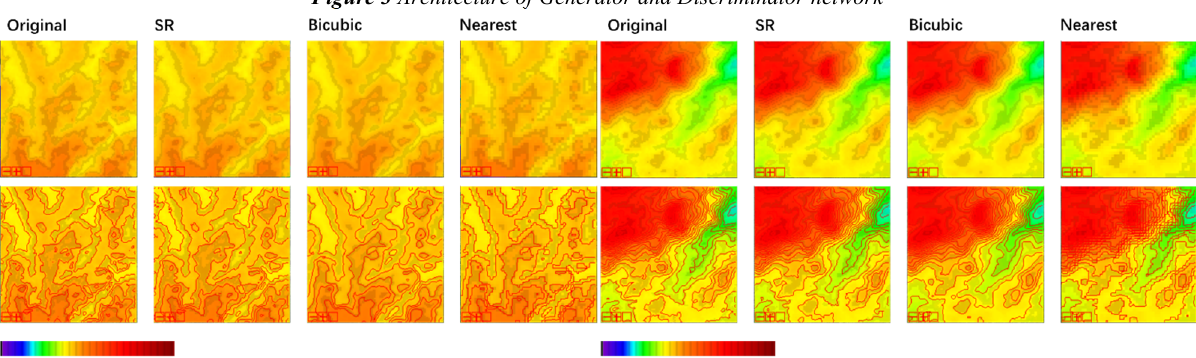
Figure 3 Architecture of Generator and Discriminator network